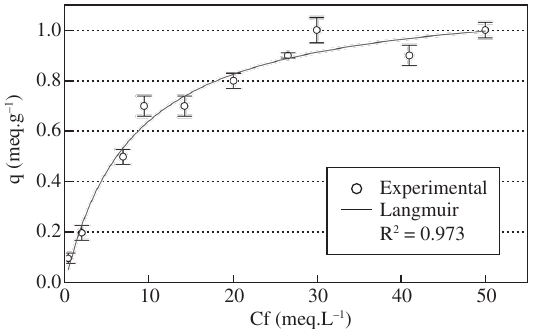
Figure 13. Reuse of powdered saturated zeolite. Equilibrium data (isotherm) for the sulphate ions uptake by BaSO -Ba-Z. Contact time: 2 hours, Ba-RZ: 4 10 g.L –1 , temperature, 25 °C, pH: 6.0.